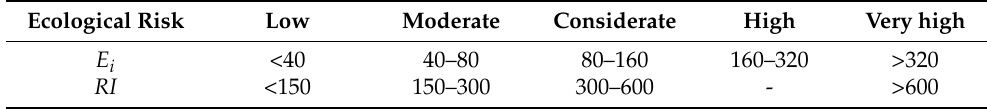
Table 3. Classification of the potential ecological risk index. Ecological Risk Low Moderate